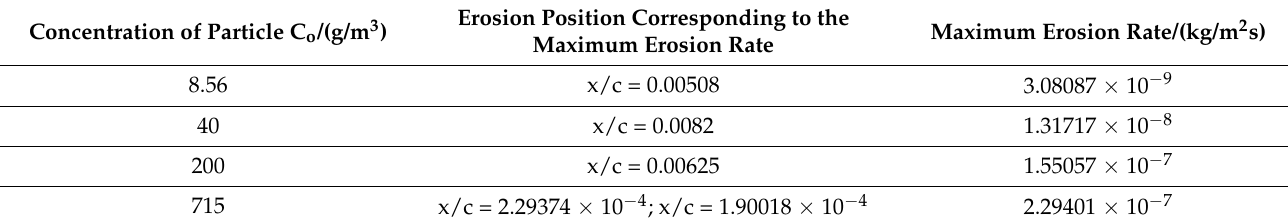
Table 1. Erosion of dynamic airfoil stall at different concentrations of particles.